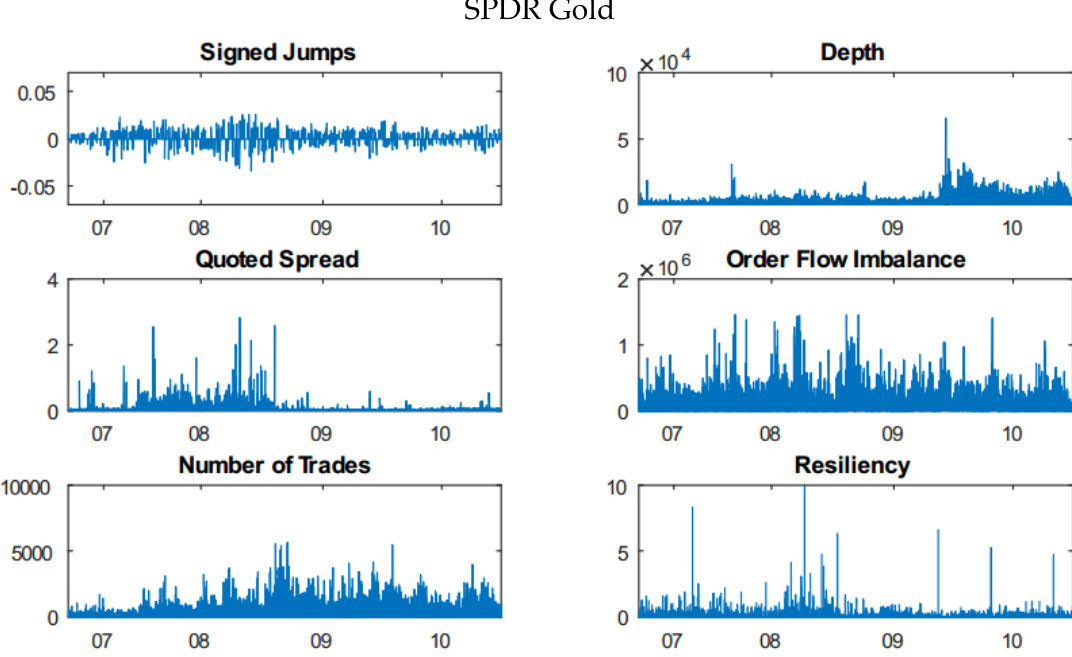
Figure 2. Intraday jumps, liquidity, and trading activity plots.